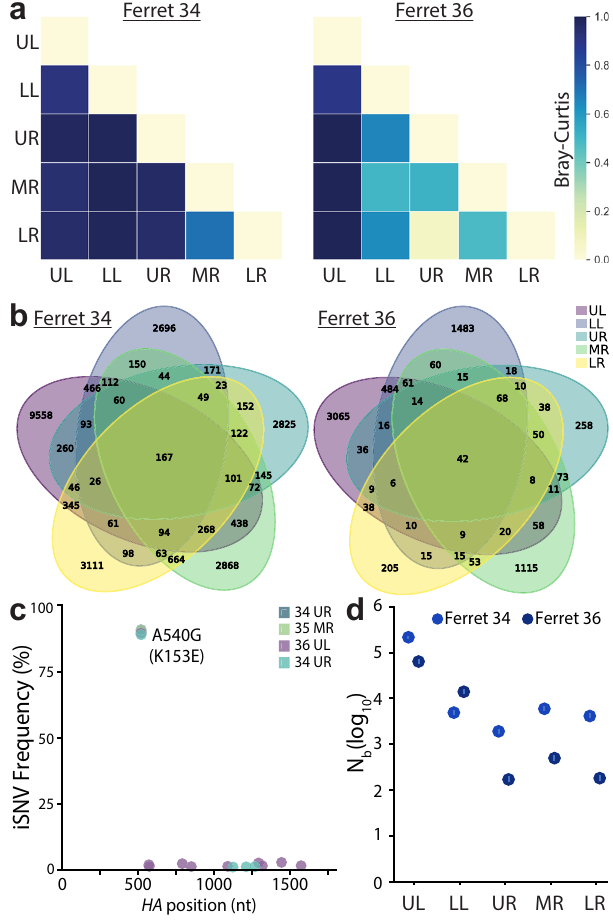
Fig. 6 Lung lineage diversity and population bottlenecks are dominated by stochastic pressures. a Pair-wise Bray-Curtis dissimilarity for lung lobes within single animals. b The number of barcode lineages common and unique to lung lobes are illustrated. c Whole-HA sequencing of virus in lung homogenates identi fi ed multiple iSNVs, but did not rose above the 3% threshold set for accurate estimation of iSNV frequency. d Transmission bottlenecks ( N b ) from nasal wash 3 dpi to each lung lobe at 5 dpi were calculated by maximum likelihood estimation. 95% con fi dence intervals are shown by the lines within the dots. Source data are provided as a Source Data fi